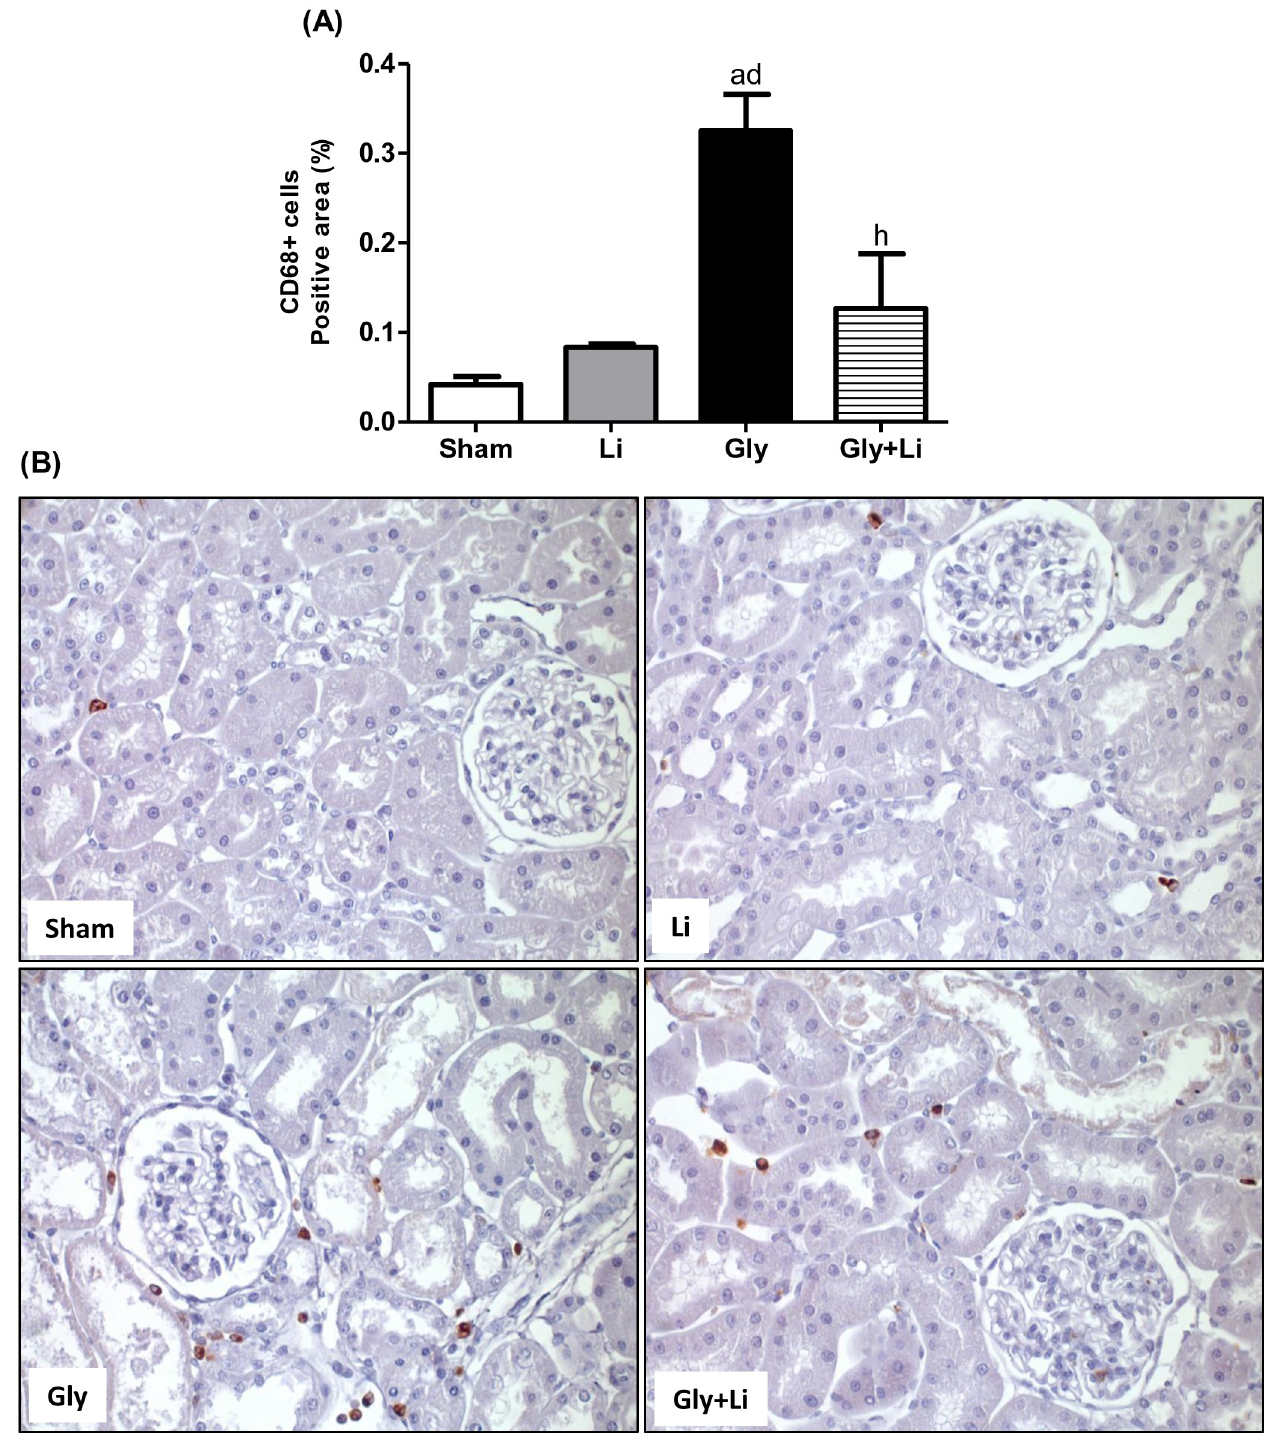
Fig 3. Immunohistochemical analysis for CD68+ cells expression in rat kidney tissue. (A) Bar graph of CD68+ cells expression values. (B) Representative photomicrographs of immunostaining for CD68+ cells in the renal cortex from a Sham, Li, Gly and Gly+Li rat (x400). Values are means ± SEM. a p < 0.001 vs. Sham; d p < 0.001 vs. Li; h p < 0.01 vs. Gly. Li, lithium; Gly, glycerol; Gly+Li, glycerol + lithium.